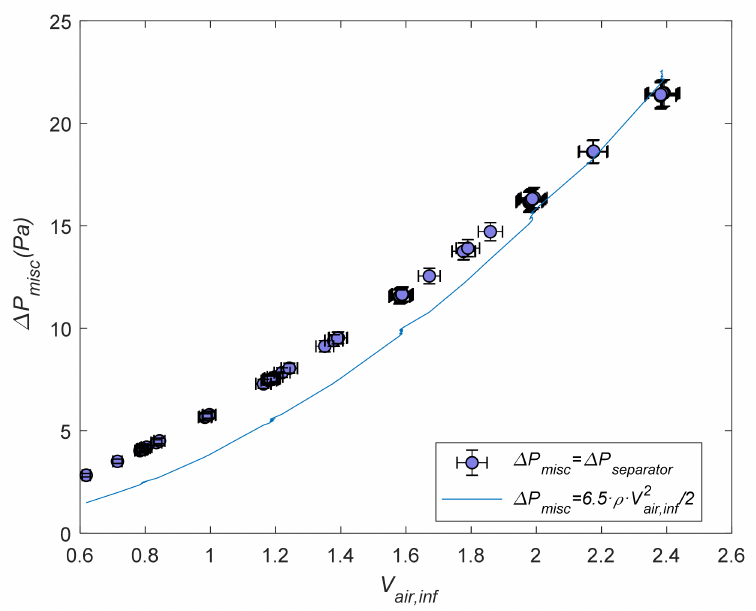
Figure 6. Pressure drop at the drop separator in comparison with the ∆ P misc calculated by Equation